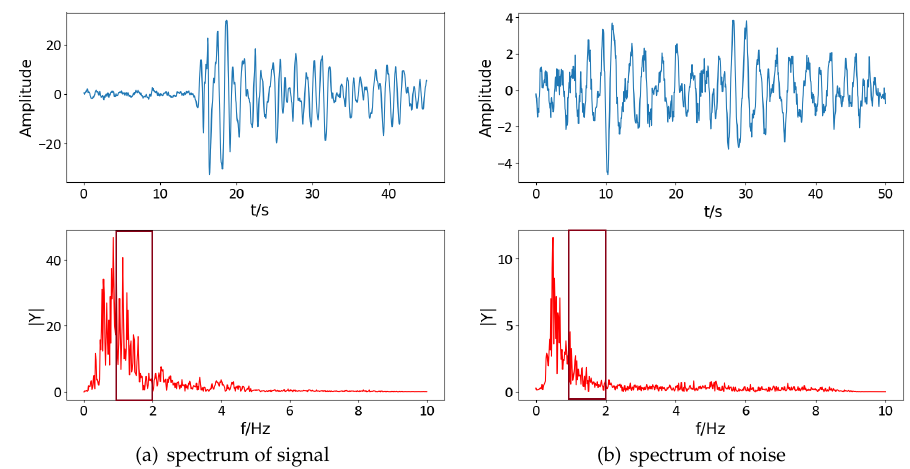
Figure 2. The FFT spectrum of seismic signal and noise. The subgraph ( a ) indicates the signal spectrum of FFT. The subgraph ( b ) is the noise spectrum of FFT. We can see that the differences between the seismic and noise spectrum are in the frequency band of 1–2 Hz.